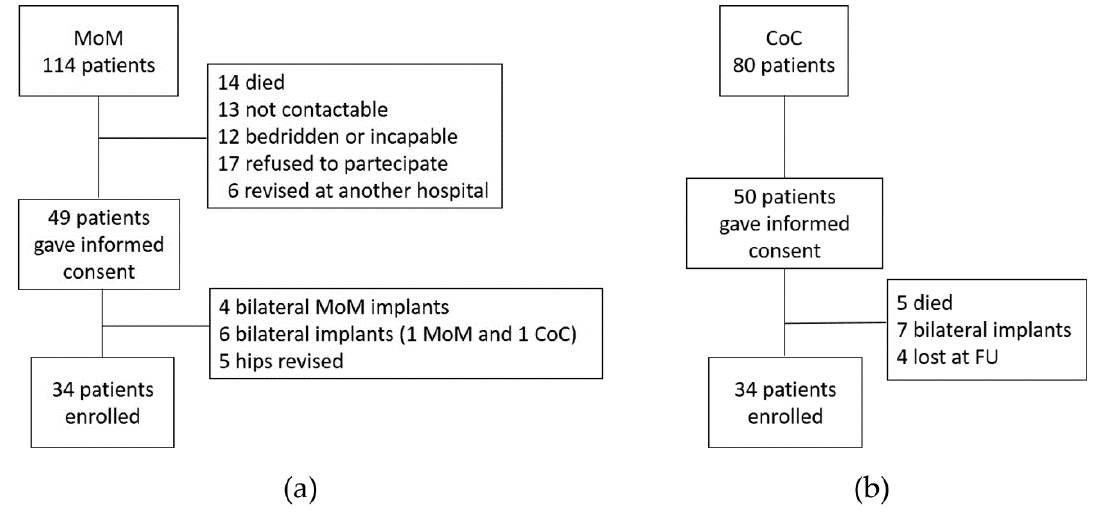
Figure 2. Flowchart summarizing patients involved in the study: ( a ) MoM, metal-on-metal bearing; ( b ) CoC, ceramic-on-ceramic bearing. FU = follow-up.